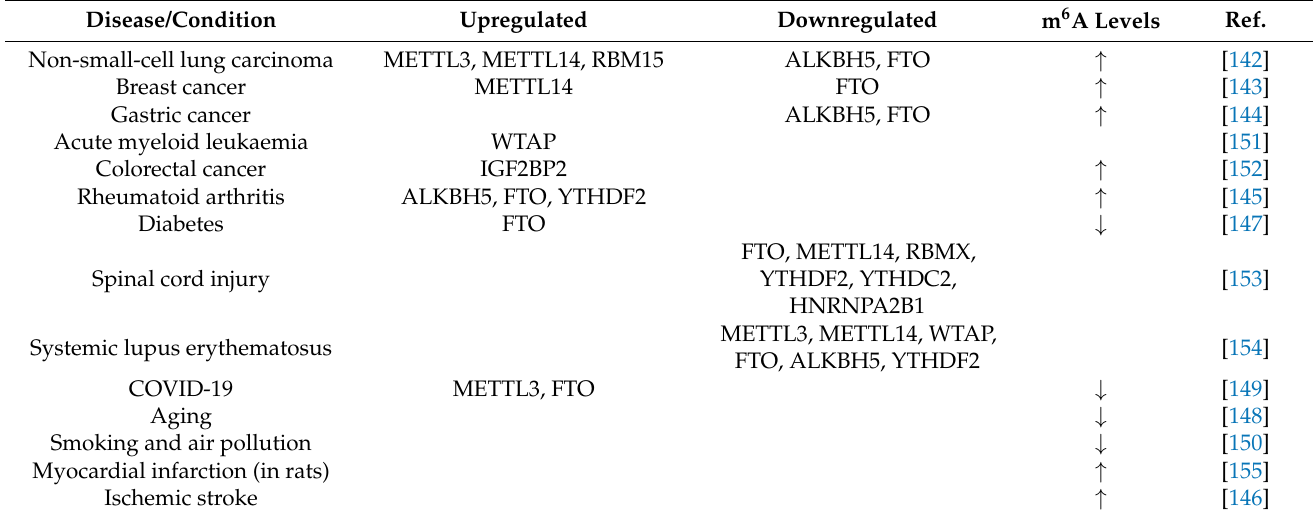
Table 1. m 6 A regulators expression direction and global m 6 A methylation status with biomarker value detected from blood. Increased and decreased m 6 A levels are depicted by up and down arrows,